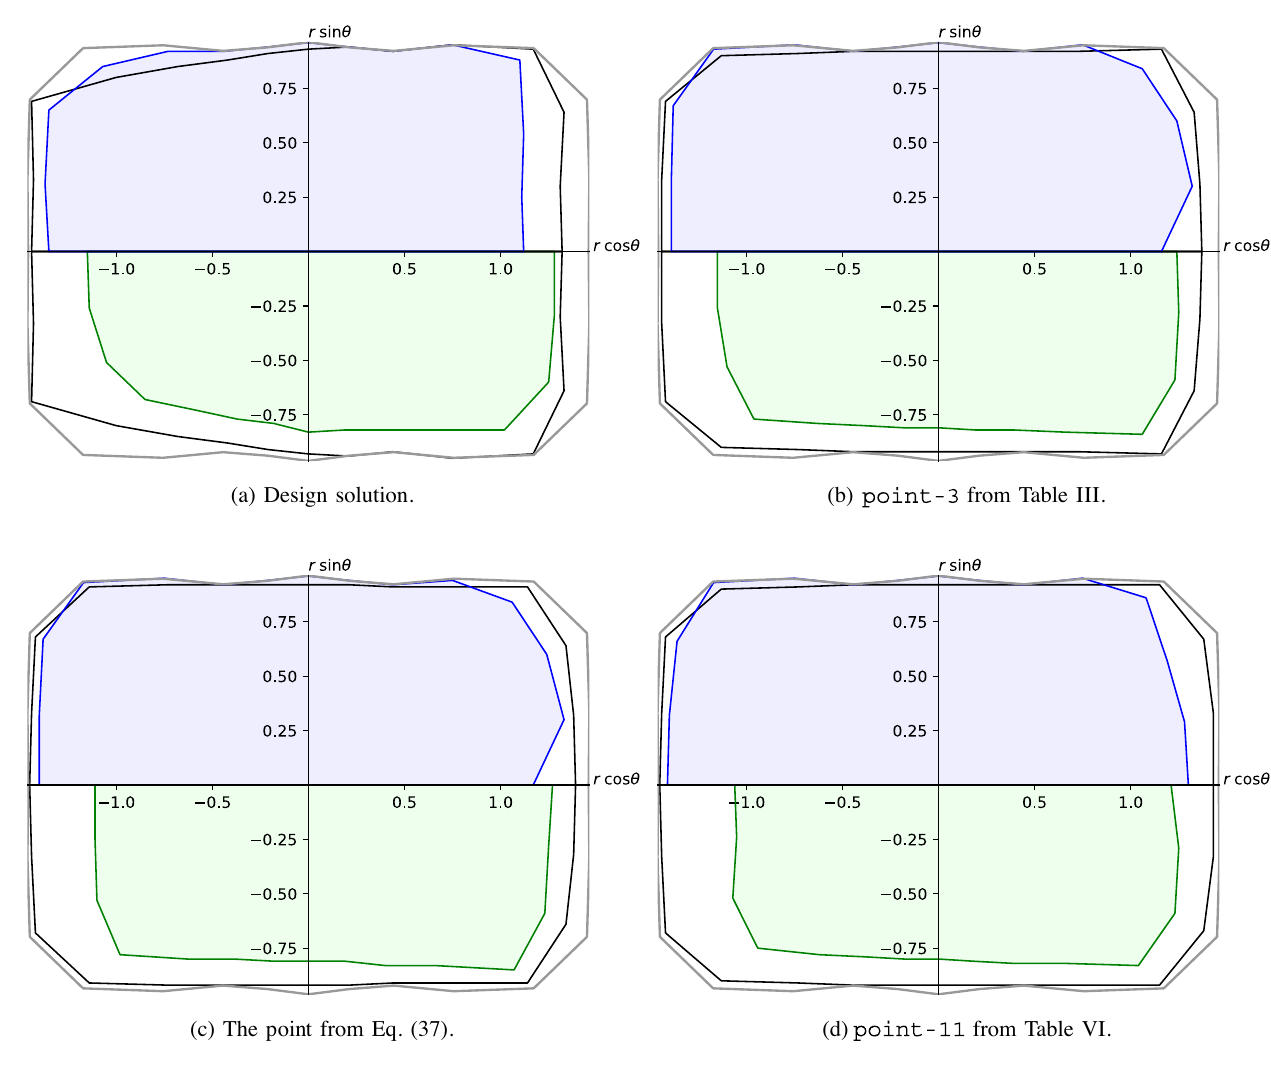
FIG. 5. Transverse DAs in Floquet space ( r cos θ ; r sin θ ) from Eq. (1) of the solution candidates for δ ¼ − 0 . 03 (green), δ ¼ 0 . 03 (blue) and δ ¼ 0 (bold black line), computed using TRACY as described in Sec. II A. The particles are tracked for 500 turns. The linear aperture, computed from the lattice model by ignoring sextupolar and higher-order fields, is shown in gray. For a clearer presentation of the results, only half of the off-momentum apertures is shown. This is sufficient due to machine-plane symmetry. Each subplot corresponds to one candidate solution: the manually obtained solution (referred to as the “ design solution, ” top left), point-3 from Table III (top right), the design point from Eq. (37) (bottom left) and point-11 from Table VI (bottom right). The relative relationships of the DA area sizes are consistent with the computed objective function